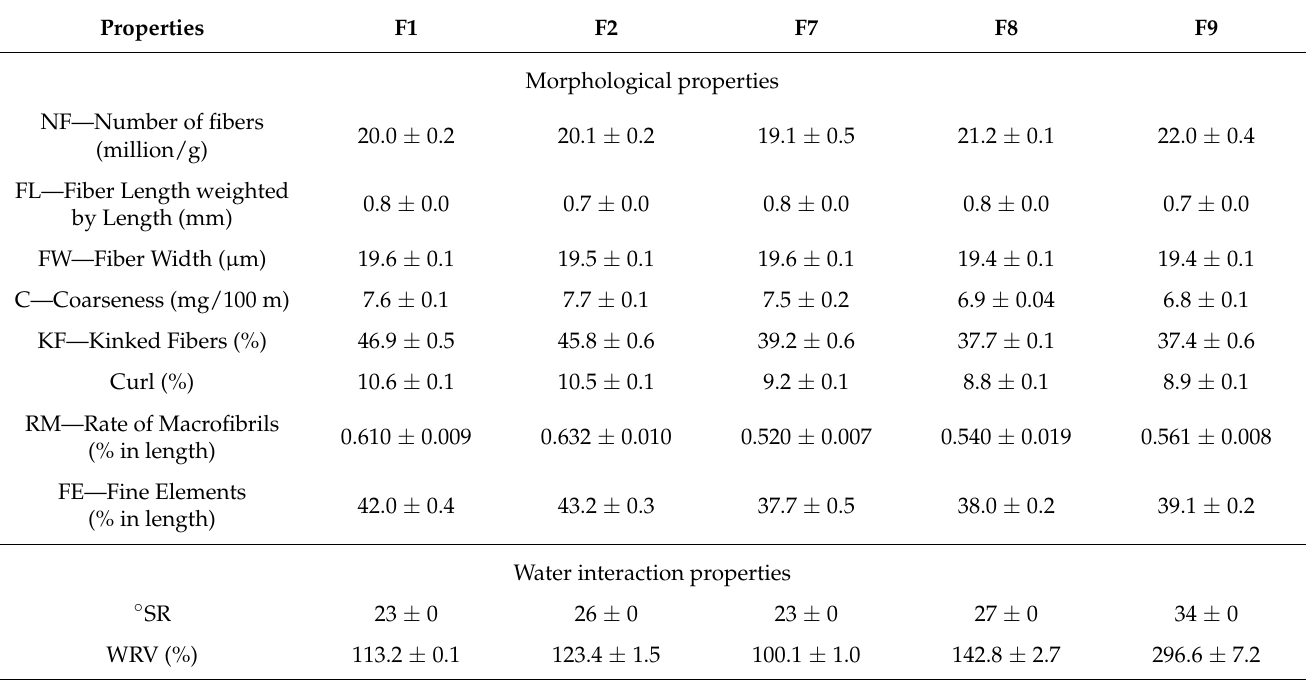
Table 4. Morphological and water interaction of formulations